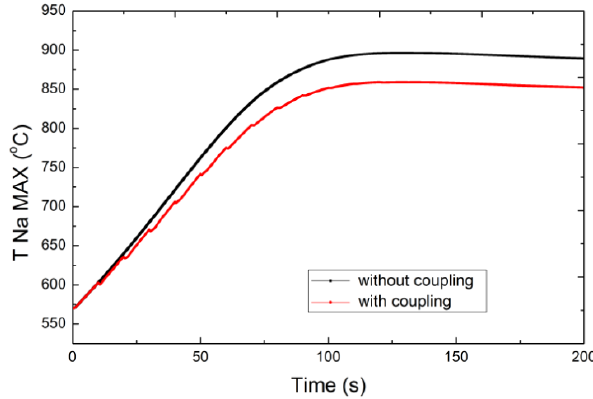
Fig. 15. Sodium maximal temperature during ULOF/PP accident with and without coupling.